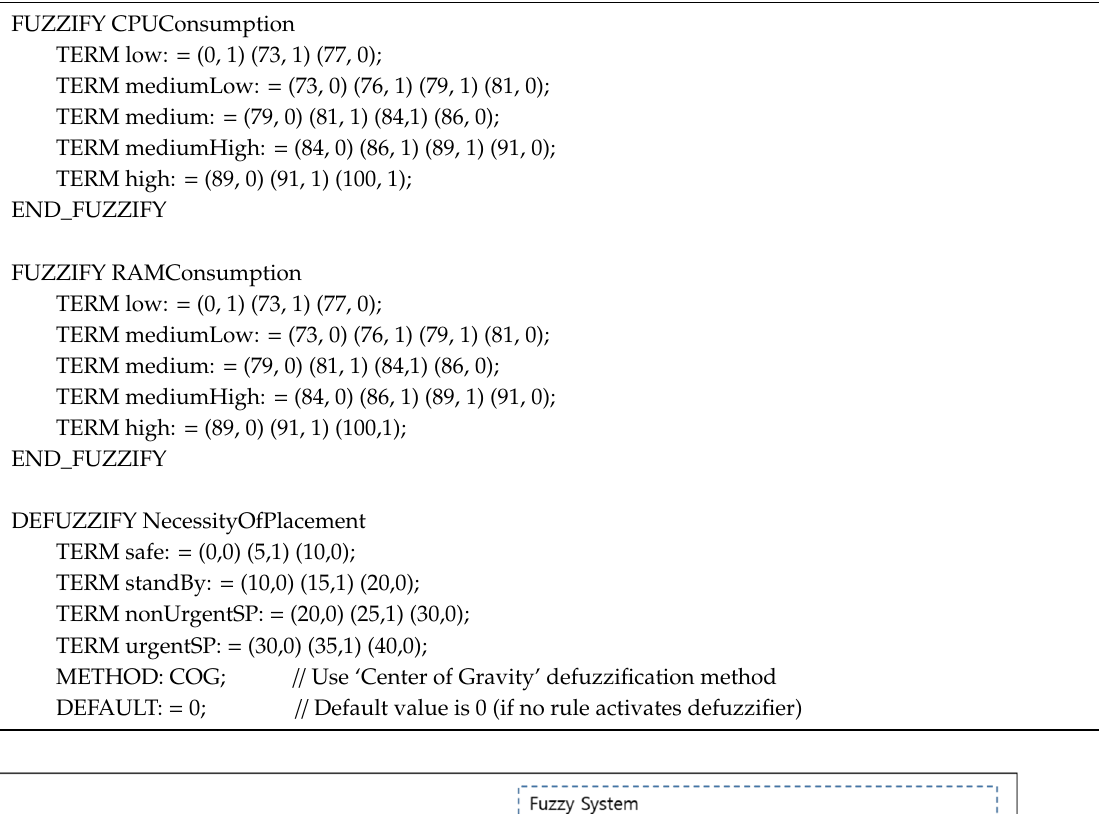
Algorithm 1: Fuzzy block (fuzzify and defuzzify setting).